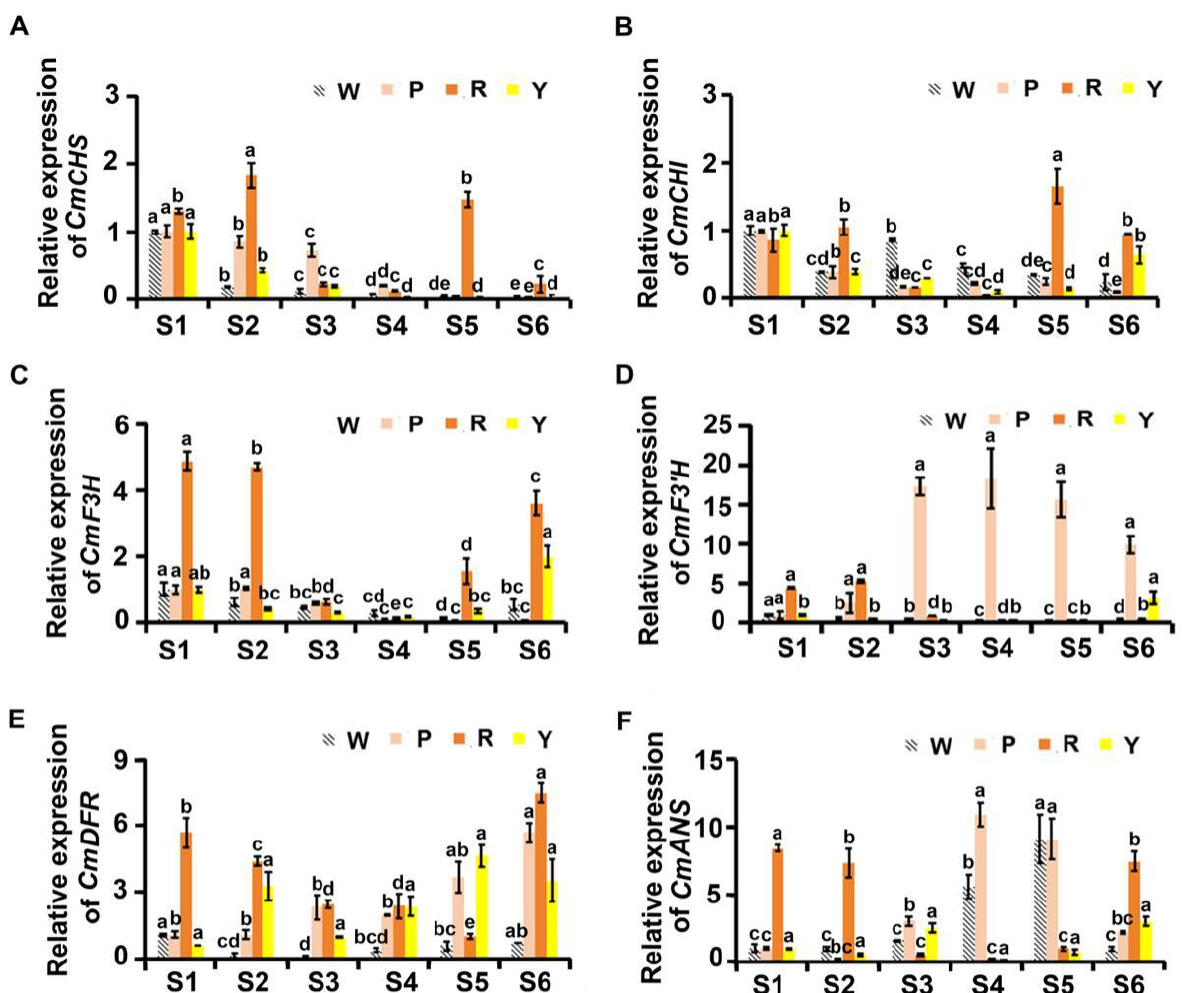
Figure 5. The relative expression of anthocyanins biosynthetic genes in four colored chrysanthemums. ( A – F ) The relative expression of CmCHS , CmCHI , CmF3H , CmF3′H , CmDFR , and CmANS in ray florets of four colored chrysanthemums at six flowering stages. Data are shown as the mean ± standard error of the mean, based on more than three replicates. Different letters indicate significant differences at p < 0.05 according to the Duncan’s multiple range test.